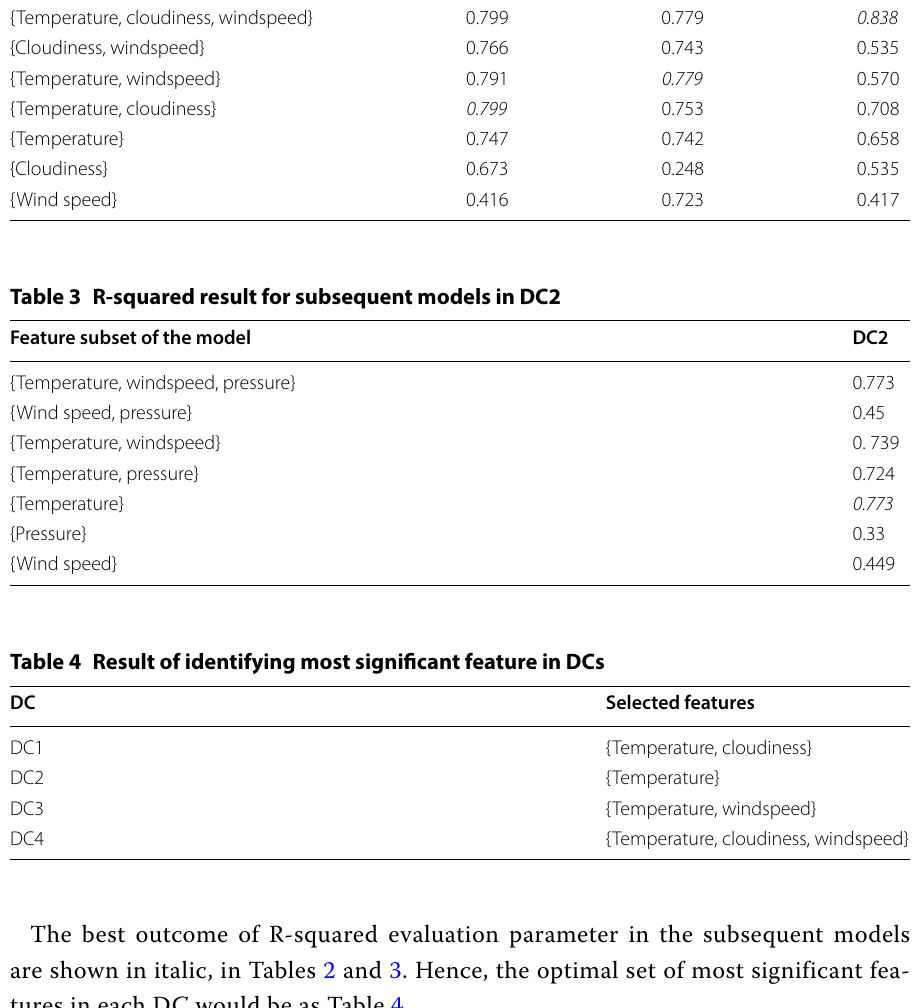
Table 2 R-squared result for subsequent models in DC1, DC3 and DC4 Feature subset of the model